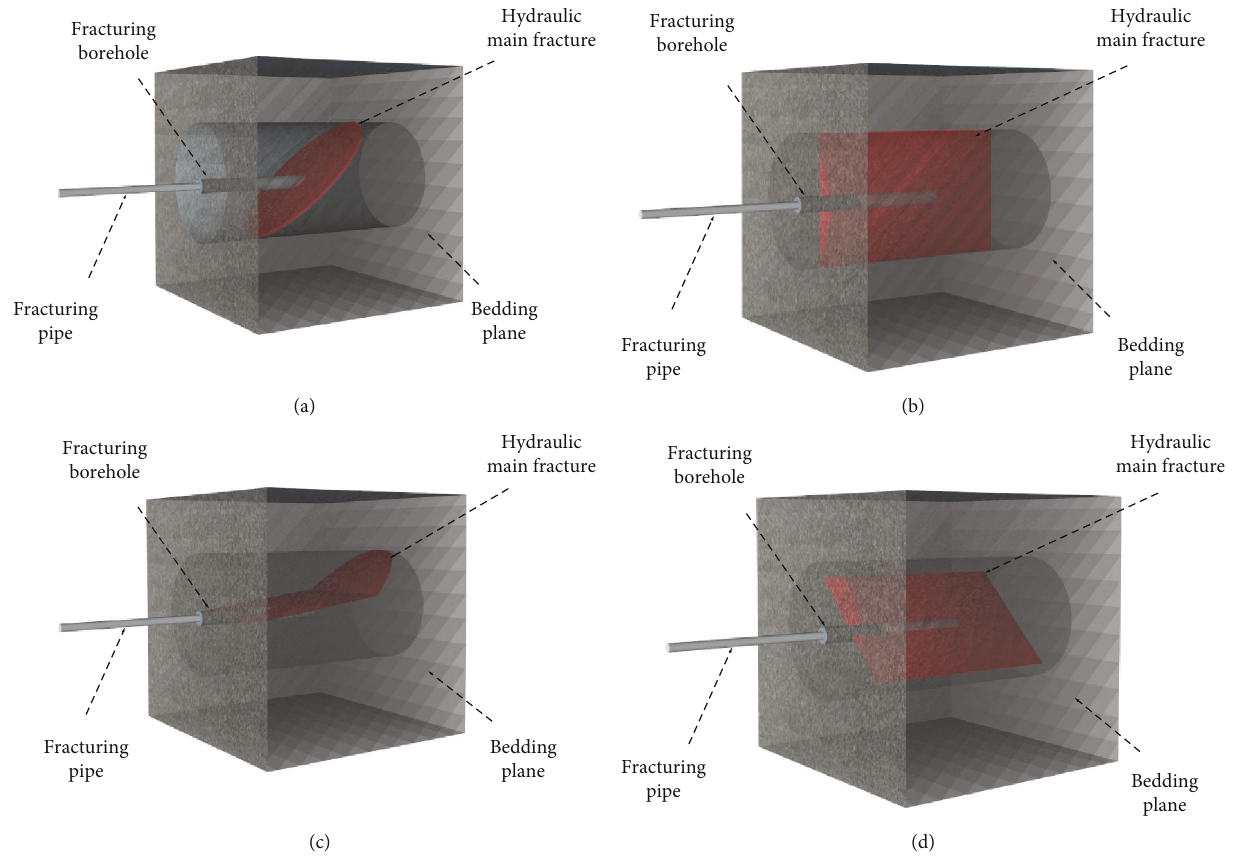
Figure 10: Propagation models of hydraulic fractures. (a) Model a. (b) Model b. (c) Model c. (d) Model